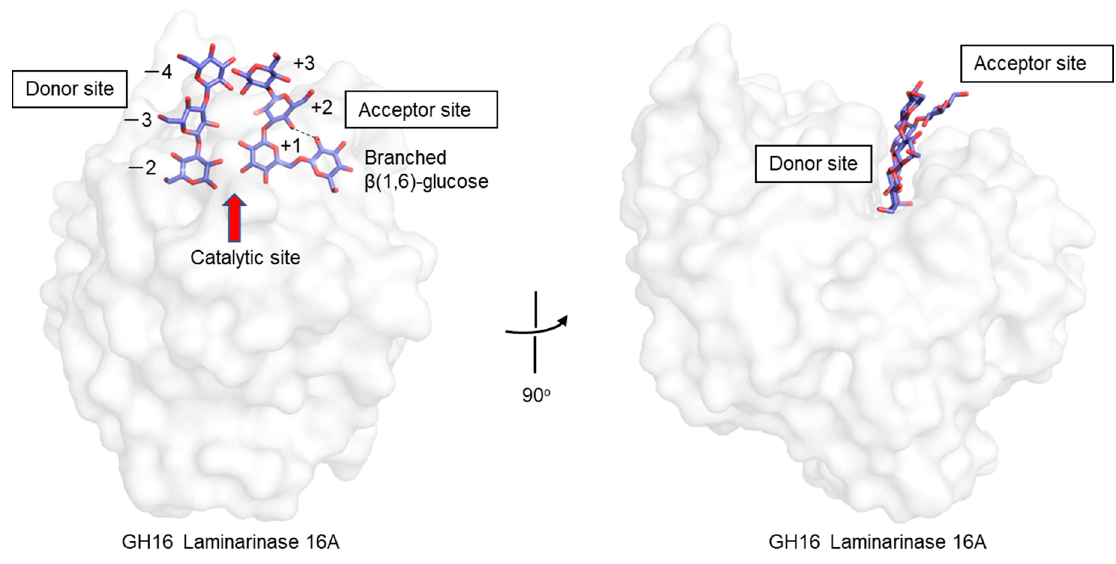
Figure 6. Crystal structure of a GH16 laminarinase in complex with products of laminarin. Proteins are shown in the surface model and β -glucan chains in stick representation. A hydrogen bond between β (1,6)-side chain and main chain glucose residue (+2 position) is shown as a dashed line.